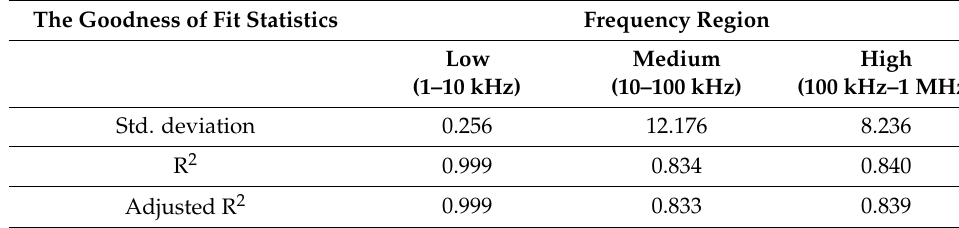
Table 13. Regression analysis for H1-H3 vs. H2-H1.